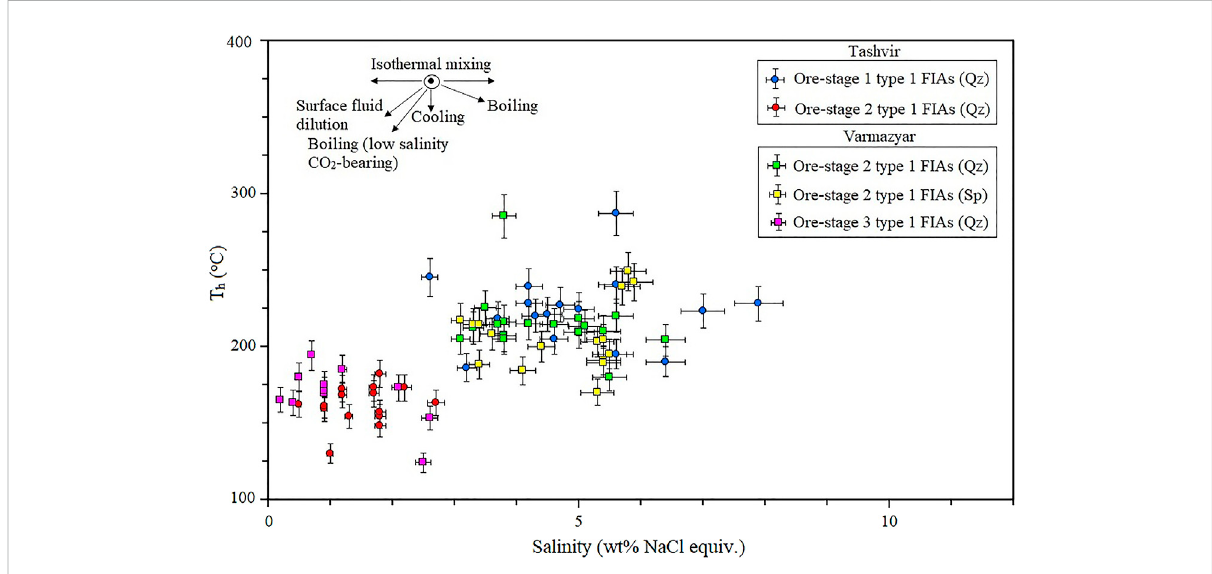
FIGURE 11 T h -salinityplotshowingtheevolutionofFIsrepresentingore-forming fl uidsfordifferentore-stagesattheTashvirandVarmazyardeposits.Inset illustrates the different fl uid evolution paths based on Wilkinson